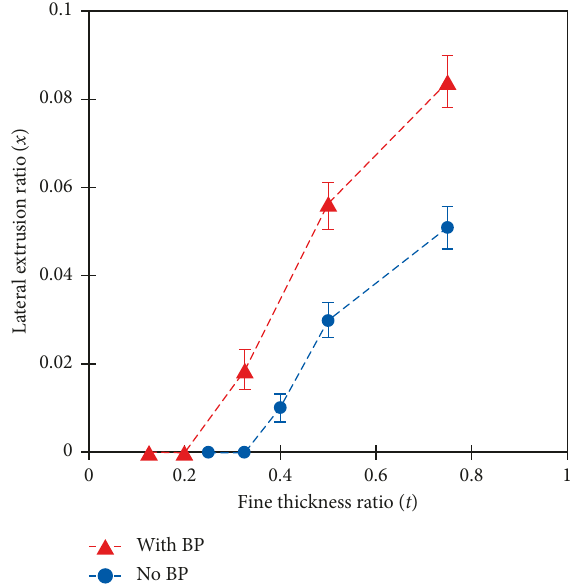
Figure 2: Measured dependence of the lateral extrusion ratio on the fin thickness ratio, under a back pressure of 110MPa and also without back